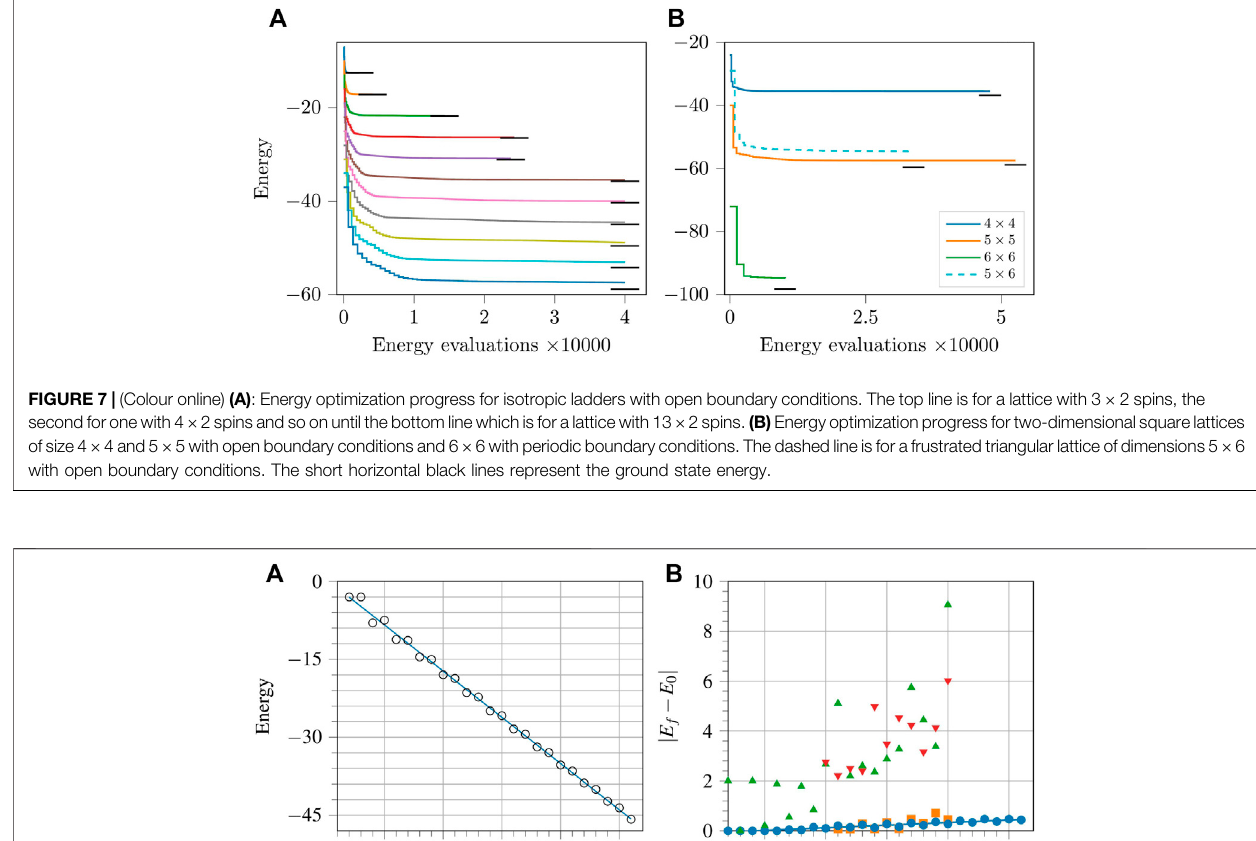
Frontiers in Physics |